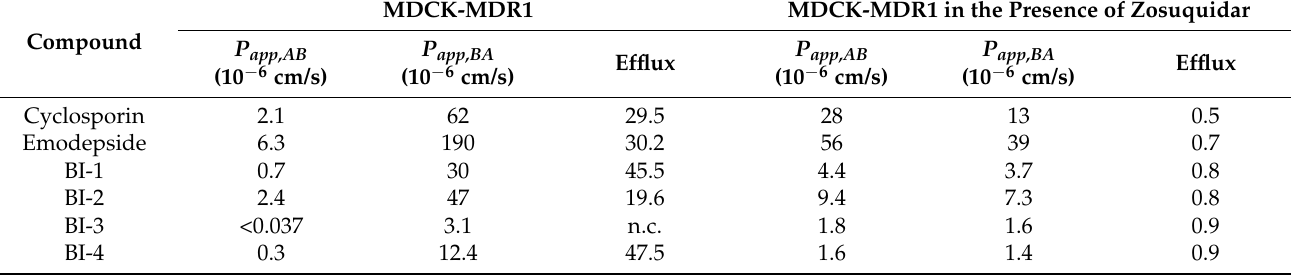
Table 5. Modified bidirectional permeability assay with MDCK-MDR1 cells. Data are mean values of duplicates. Final concentration of compounds in donor compartment was 1 µ